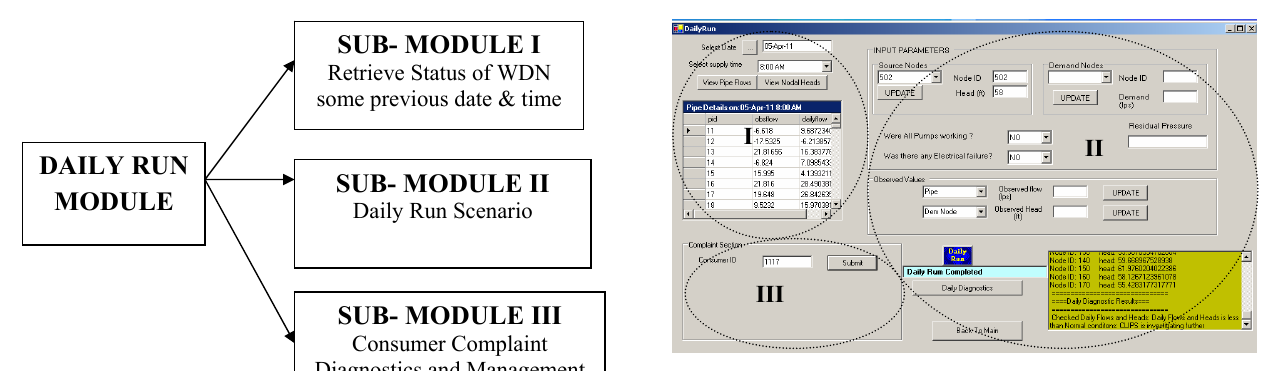
Figure 9. Screen shot of Daily Run Module of DSS showing sub- Fig. 10. Working of CLIPS for Sub-ModuleII Fig. 9. Screen shot of Daily Run Module of DSS showing sub-